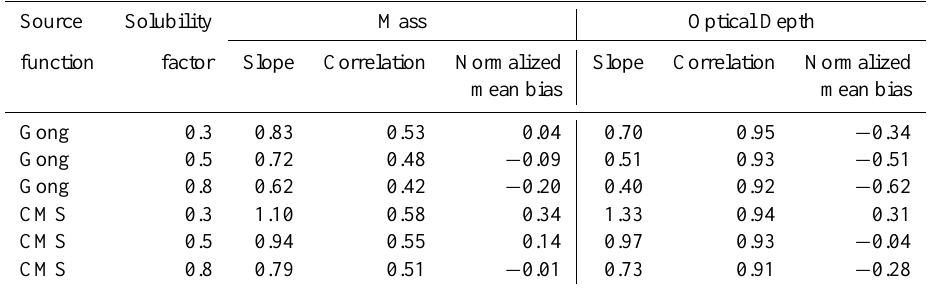
Table 3. Slopes, correlation coefficients, and normalized mean biases of the linear fits of the measured and modeled mass and optical depth in 1994. The mass data are from the University of Miami global network of aerosol measurements (Savoie and Prospero, 1977). The optical depth data follows the wind speed dependence measured at Mace Head (Mulcahy et al., 2008). Source Solubility Mass Optical Depth function factor Slope Correlation Normalized Slope Correlation Normalized mean bias mean bias Gong 0.3 0.83 0.53